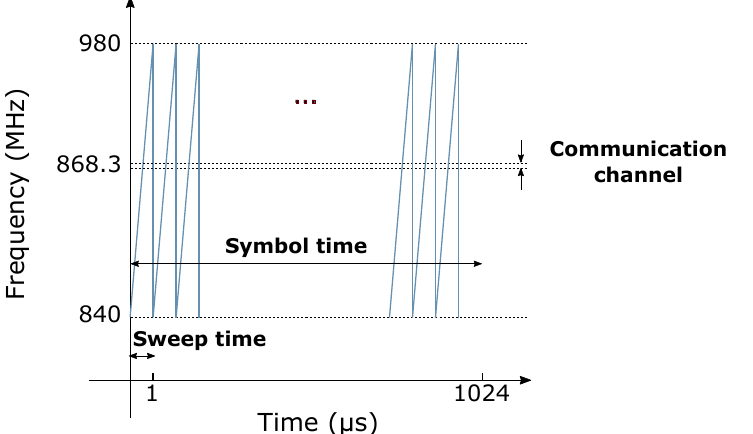
Figure 4. Time–frequency representation of a 1µs jamming signal. This graph shows that, during T sym = 1.024ms, a SF = 7 LoRa receiver is subject to 1024 jamming signal